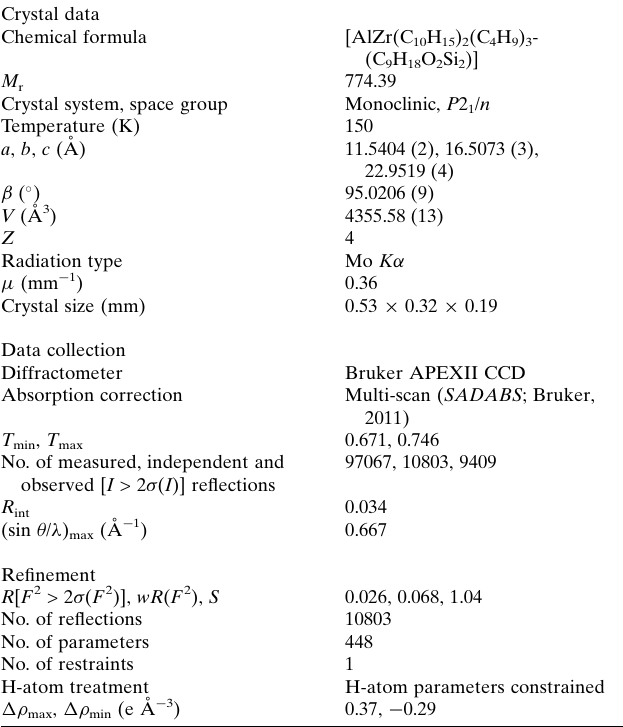
Table 1 Experimental details. Crystal data Chemical